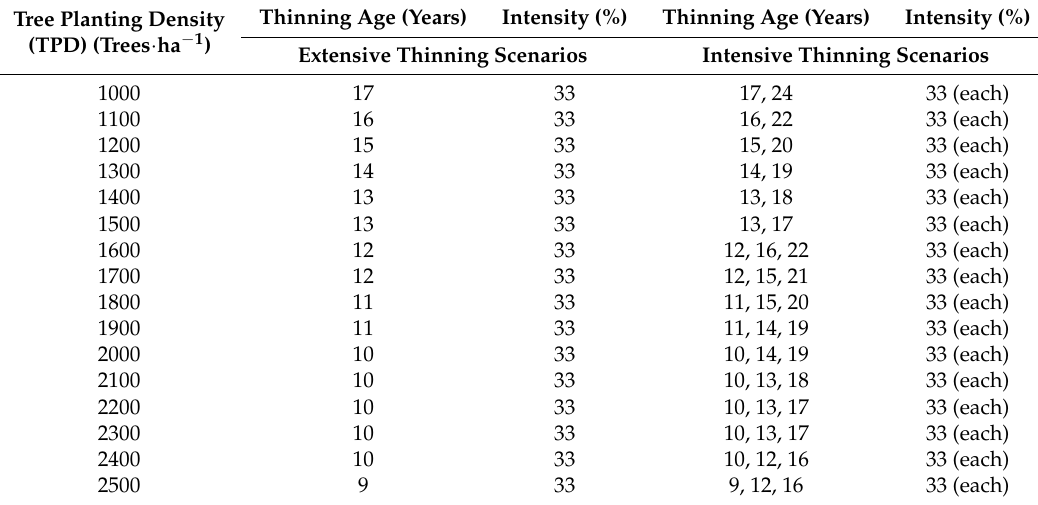
Table 2. Thinning scenarios for slash pine for different tree planting